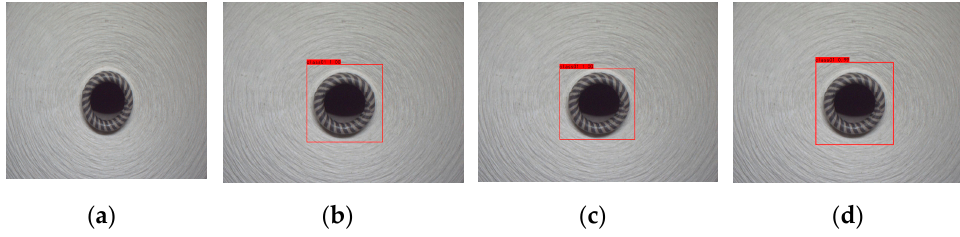
Figure 12. Identification of normal cone yarn with black twill bobbin : ( a ) original image; ( b ) YOLOv3 + DarkNet-53 algorithm recognition results; ( c ) Faster R-CNN + VGG16 algorithm recognition results; ( d ) Faster R-CNN + ResNet50 algorithm recognition results.